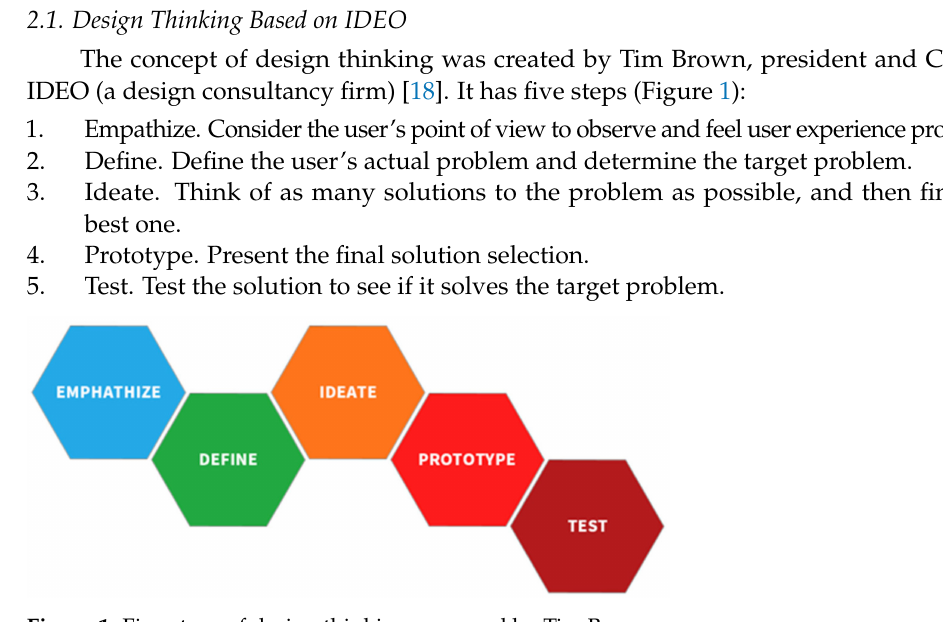
Figure 1. Five steps of design thinking proposed by Tim